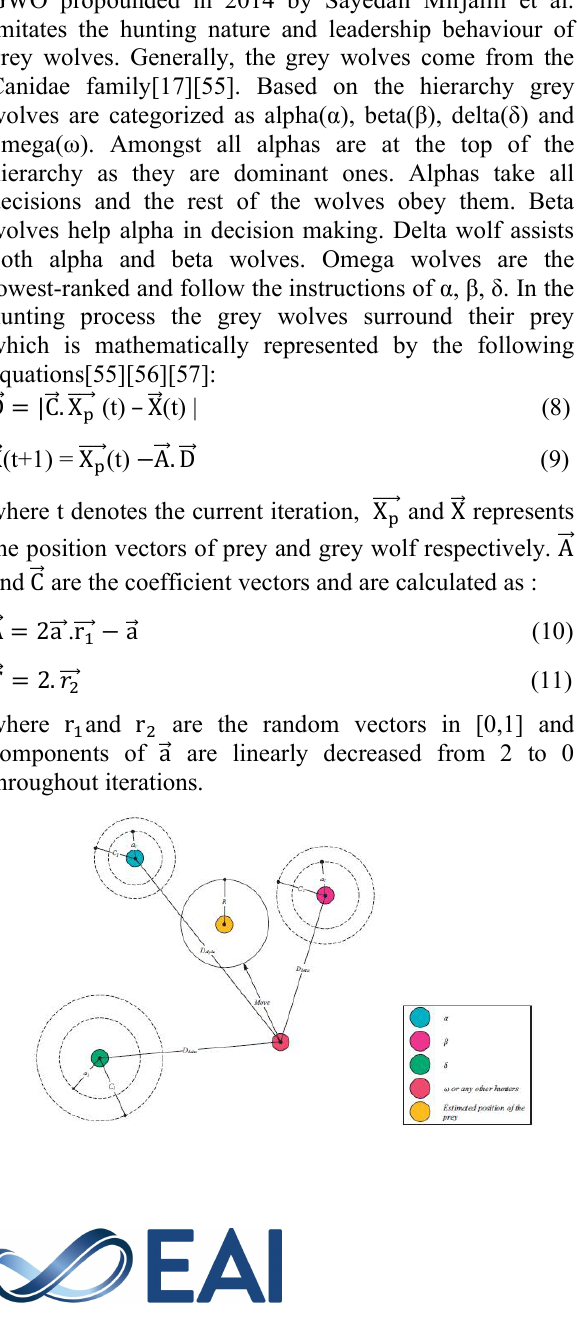
Figure 3. Position updation principles of dragonflies[52]